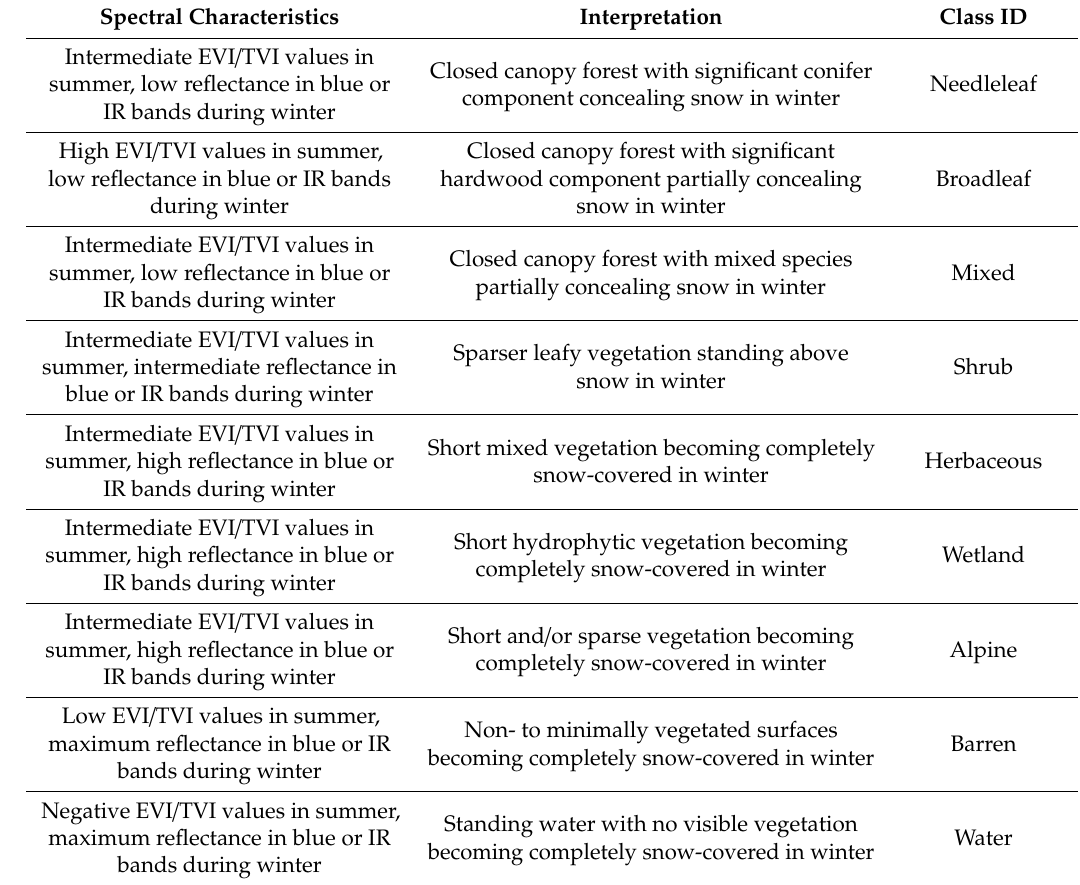
Table 2. Decision structure for interpreting vegetation types from Landsat